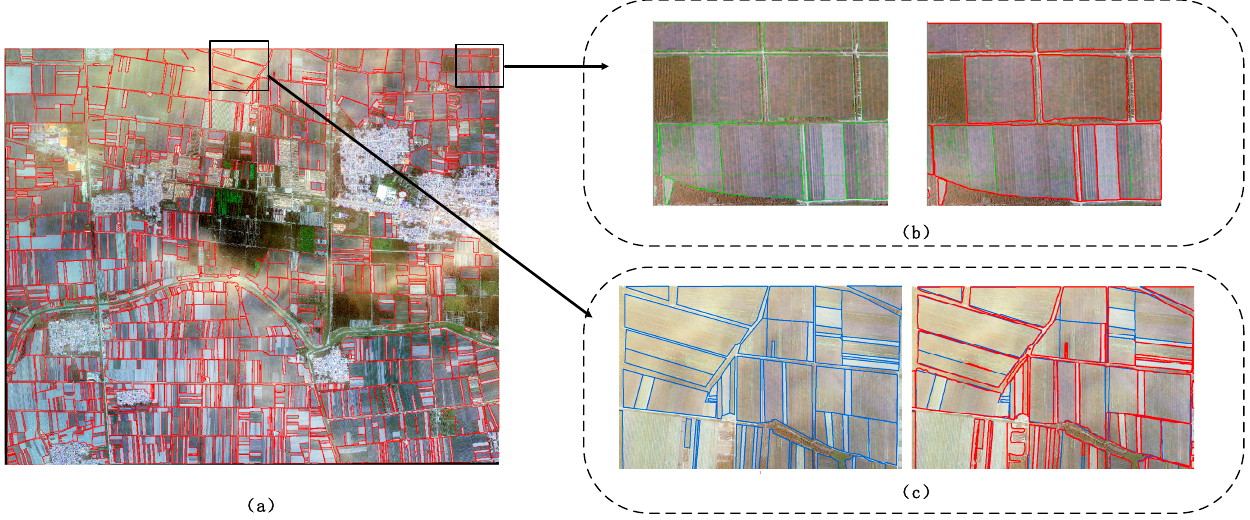
Figure 11. Full image output after post-processing and some of the zoomed-in details. ( a ) The original remote sensing image and the results obtained by our network through post-processing. ( b , c ) Detail drawing of local area.